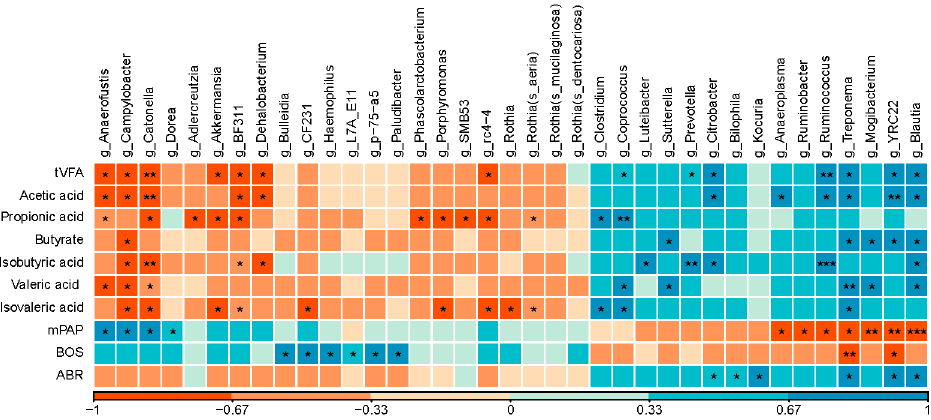
Figure 4. Pearson correlation matrix between genera and the physiological indicators of heifers. The scale of the colors is denoted as follows: the more positive the correlation (closer to 1), the darker the shade of blue; the more negative the correlation (closer to − 1), the darker the shade of red. ABR = average breathing rates; mPAP = mean pulmonary arterial pressure; BOS = blood oxygen saturation; tVFA = total volatile fatty acid. *: p < 0.05; **: p < 0.01; ***: p < 0.001.